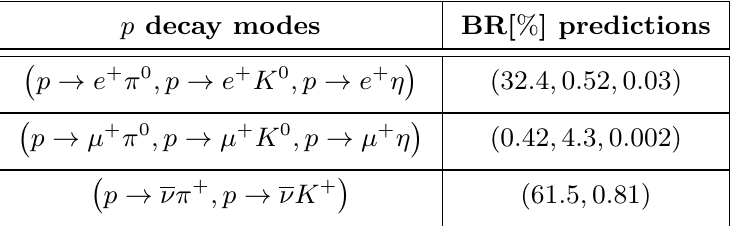
Table 5 . Proton decay branching fraction predictions of the best fit with the fixed seesaw scale, M 3 = 4 × 10 13